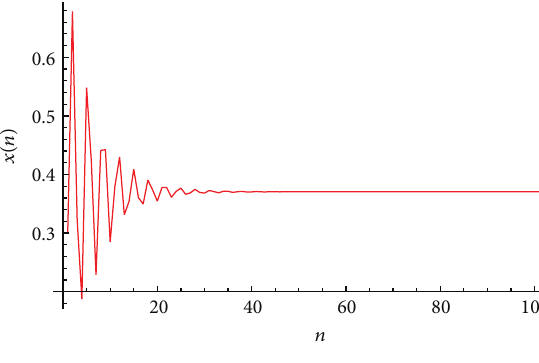
Figure 7: Plot of 𝑥 𝑛 for the system (53).